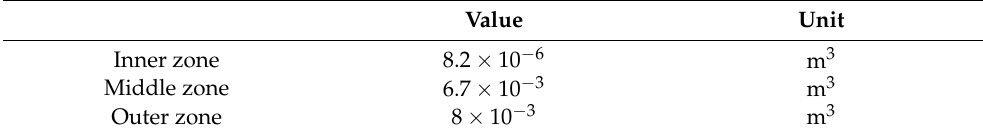
Figure 5. The XOZ section of the computational domain. Table 1. Average grid sizes of different zones.